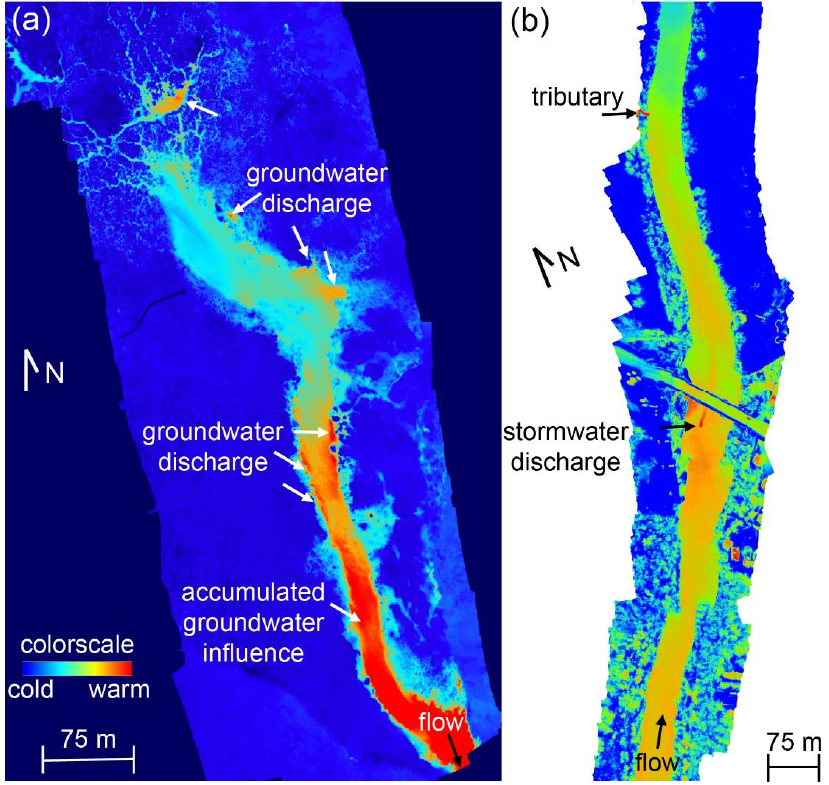
Figure 2. ( a ) A thermal IR ortho image generated from drone ‐ based data collected over a wetland